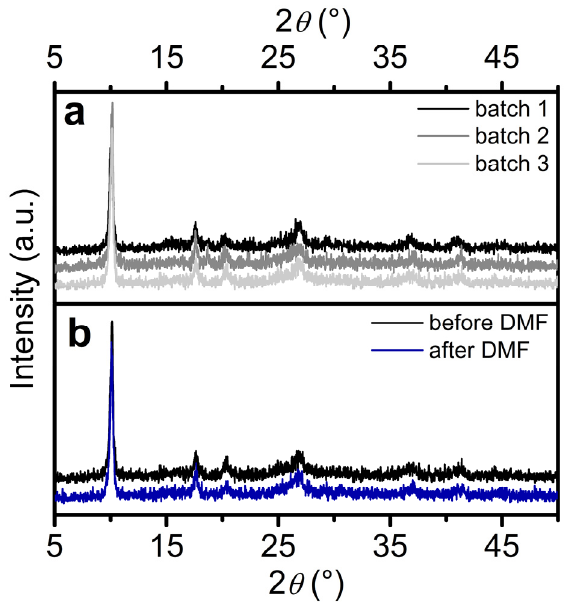
Figure 1. PXRD diffractograms of KCL-102 . ( a ) Diffraction patterns of as-synthesized KCL-102 in various batches using different reaction conditions (see Table 1). ( b ) Diffraction patterns of the as-synthesized KCL-102 before and after washing with DMF.